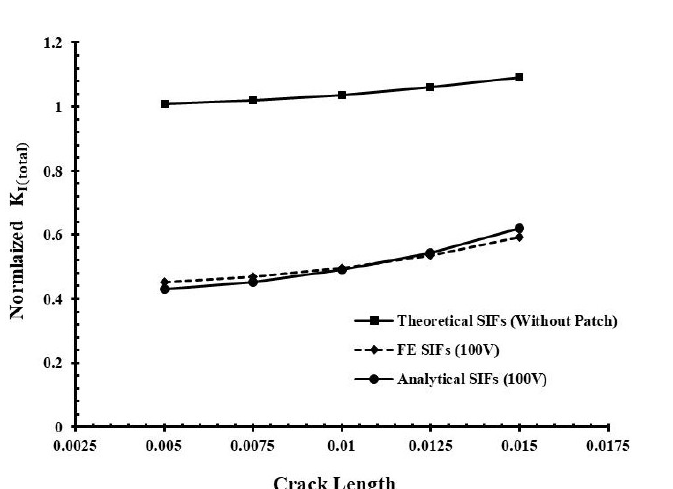
Figure 4. Comparison of the NSIFs between unpatched and patched cracks with application of 100 V.